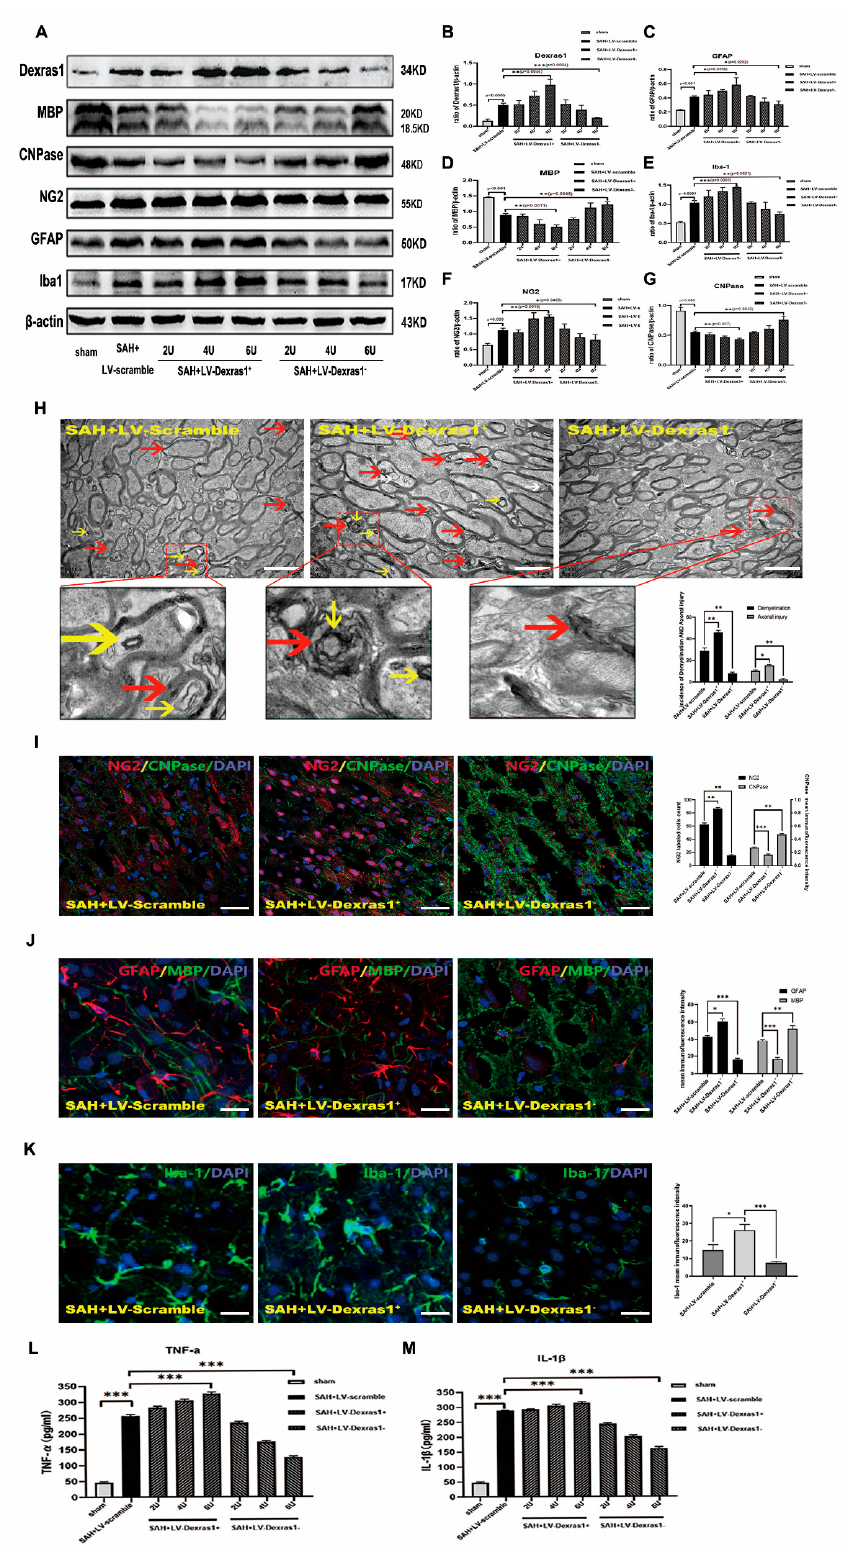
Figure 4. ( A ) Representative Western blots of Dexras1, MBP, CNPase, NG2, GFAP, and Iba1 expression in each group (sham, SAH+LV-scramble, SAH+LV-Dexras1 + and the SAH+LV-Dexras1 − with